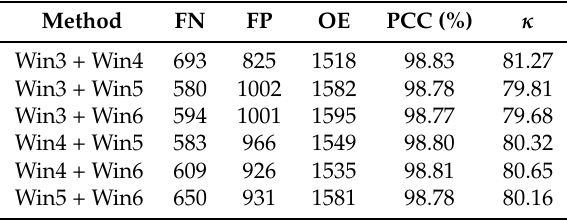
Table 7. Evaluation values of different sizes of fused blocks of the inland water data